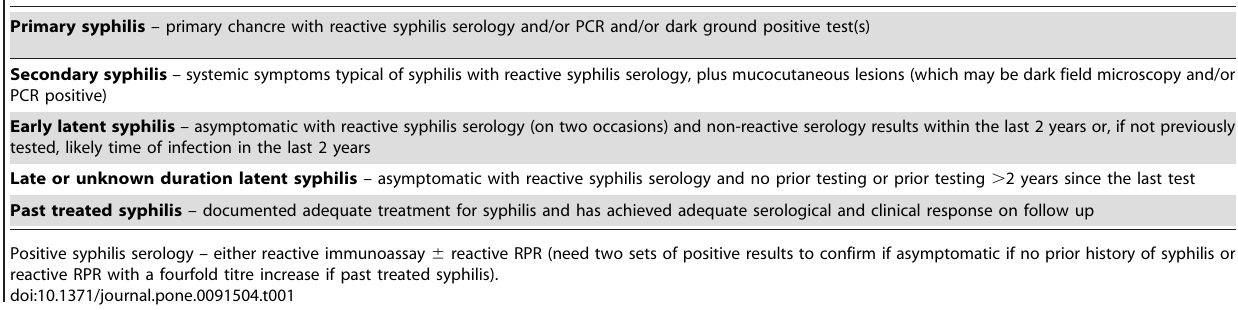
Table 1. Clinical Syphilis Case Definitions.